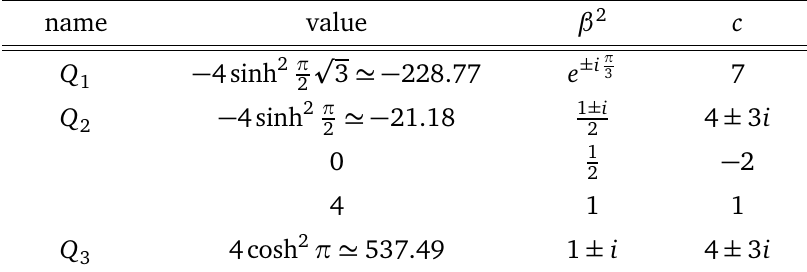
Figure 1.2: The complex c -plane, including the image of the complex Q -plane (white) via Eq. (2). Table 1.3: Some special values of the parameters Q , (cid:12) 2 and c , as related by Eq. (2) and plotted in Figures 1.1 and